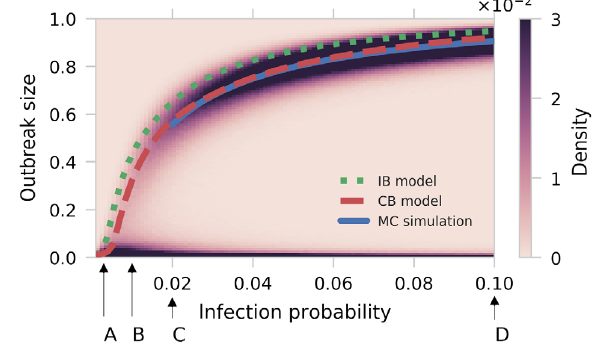
FIG. 4. Distribution of final outbreak sizes as a function of the infection probability β . We perform 10 5 MC realizations for every value of β , each starting with one randomly chosen outbreak location. For β > 0 . 02 , we show the averaged final outbreak size (blue line) with a cutoff at 20% of the population size. Estimations from the CB and IB models are presented as red dashed and green dotted lines, respectively. Labeled arrows at the bottom mark infection probabilities that correspond to Figs. 5(a) – 5(d),